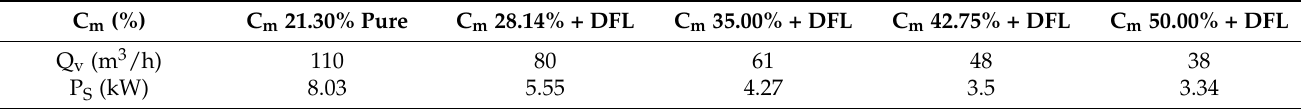
Table 4. Power consumption of the electric motor driving the centrifugal pump.